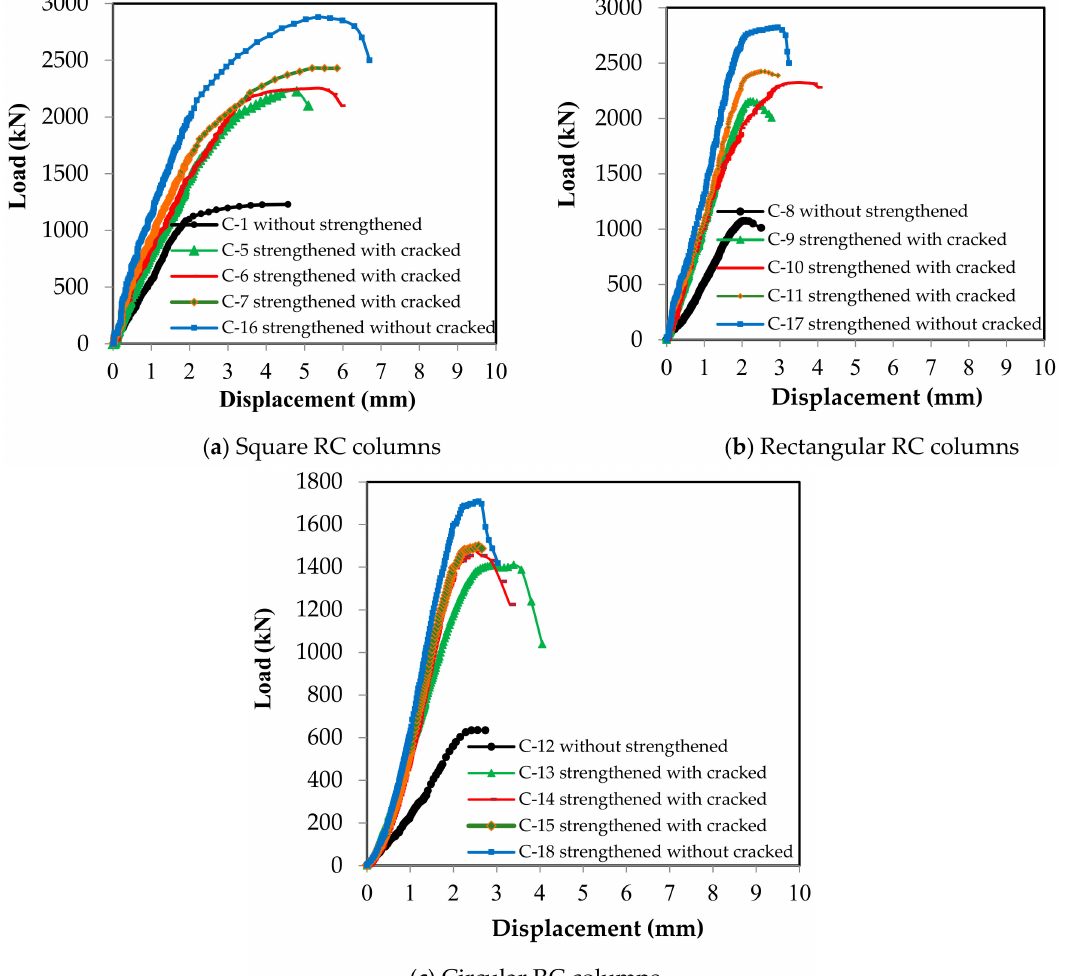
Figure 8. Load–displacement relationships for the RC